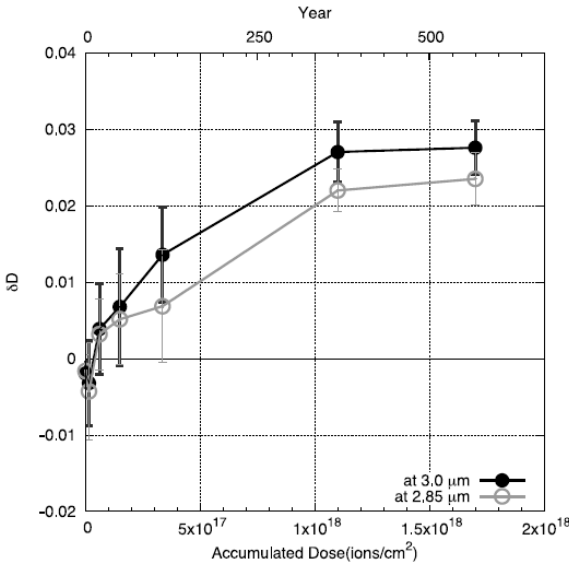
Figure 14. Change in absorption strength at 2.85 µ m and 3.0 µ m as a function of proton dose for serpentine. (Reprint Figure 6 in p.6 of Y. Nakauchi et al., Icarus 355(2021) 114140).